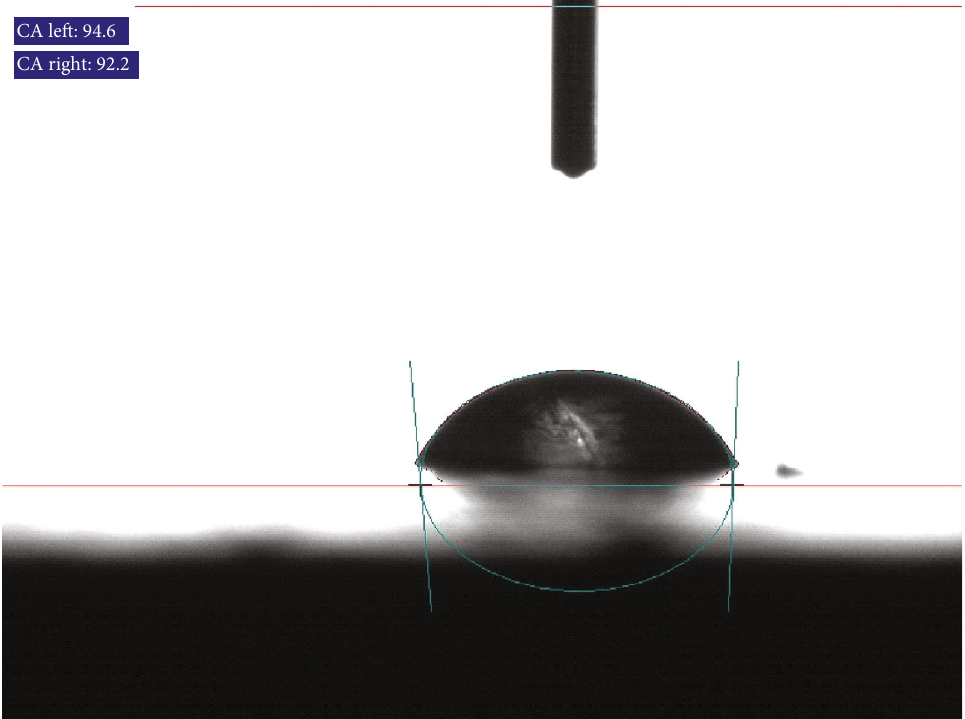
Figure 7: Contact angle and water droplet shape of wind turbine blade coated with PVDF